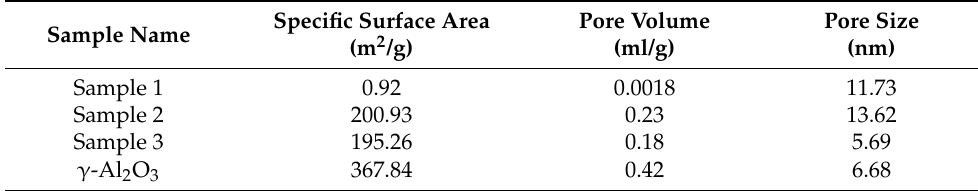
Table 2. BET of the